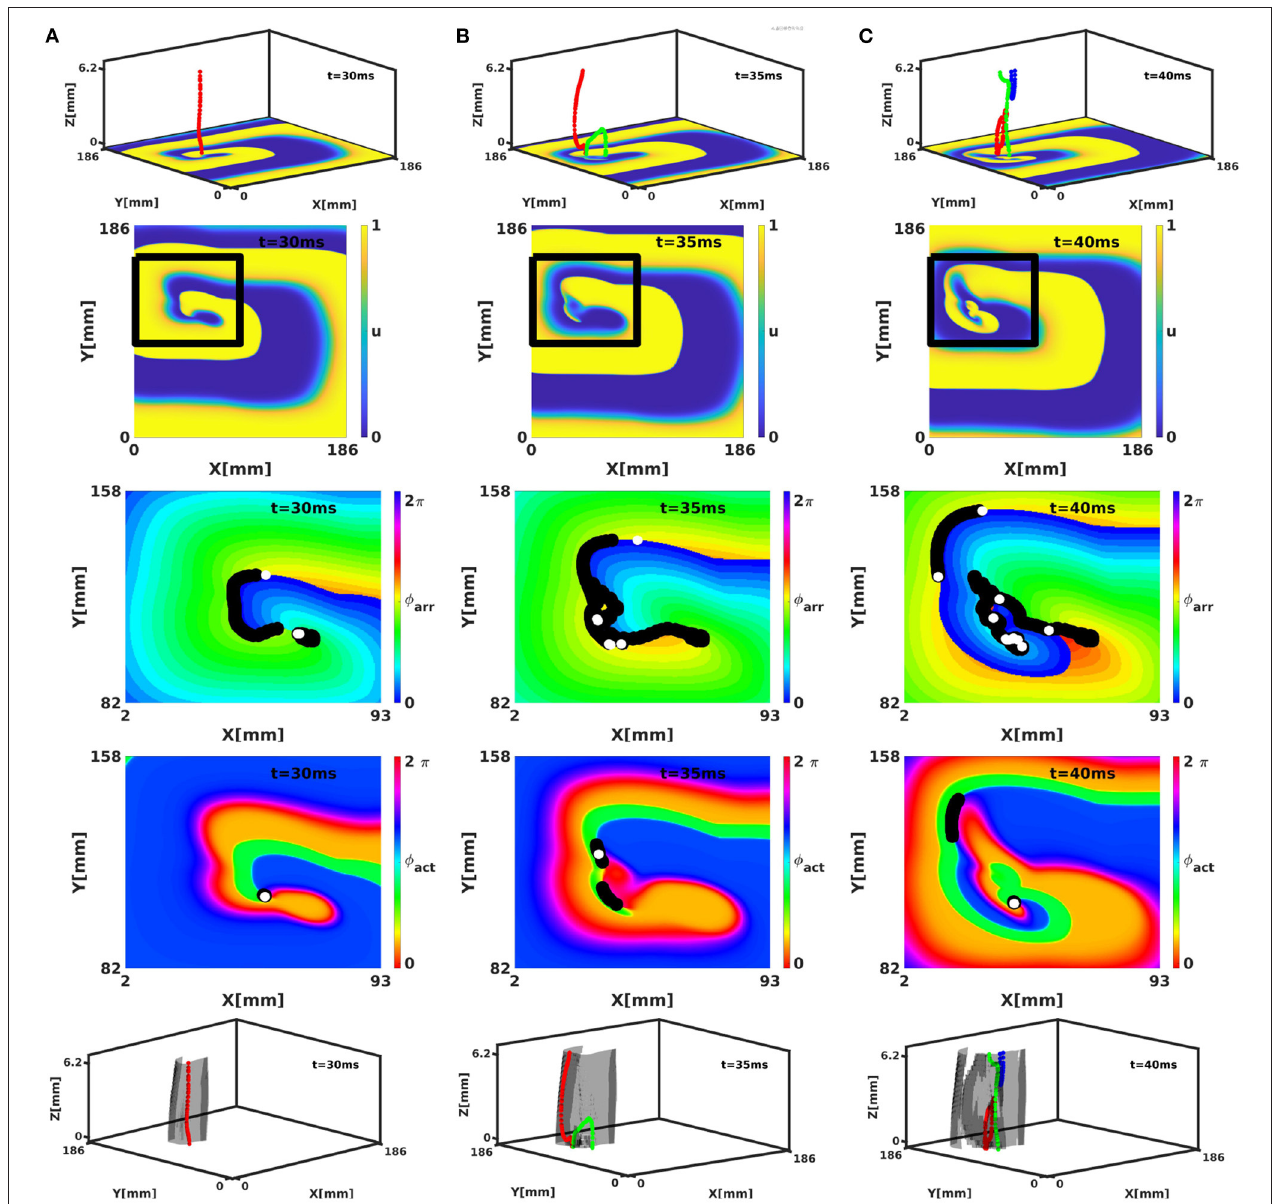
FIGURE 11 | Analysis of a break-up pattern in a 3D slab geometry with linear-core rotors and rotational anistropy in the FK model. Panels (A–C) show activity at times t 30, 35, and 40ms, respectively. The rows show respectively 3D activity with filaments (colors indicate different filaments), normalized transmembrane voltage on = the bottom surface, and analysis of the surface patterns in terms of φ arr and φ act and 3D activity with filaments colored as above and PDSs indicated in gray. Note that several phase defects are observed, indicating conduction block near the spiral wave